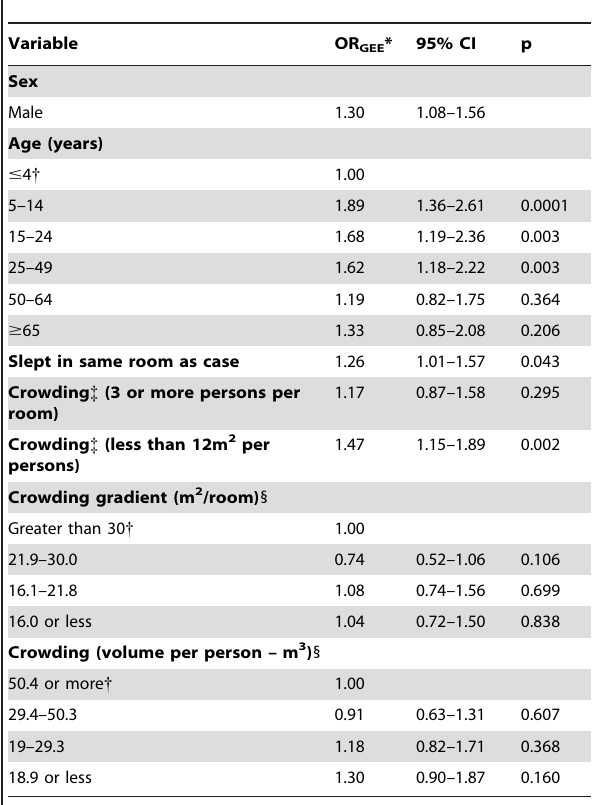
*Crude Odds Ratios adjusted for intra-household correlations with Generalized Estimating Equations (assumptions: exchangeable matrix, logit link function and binomial family). { Reference